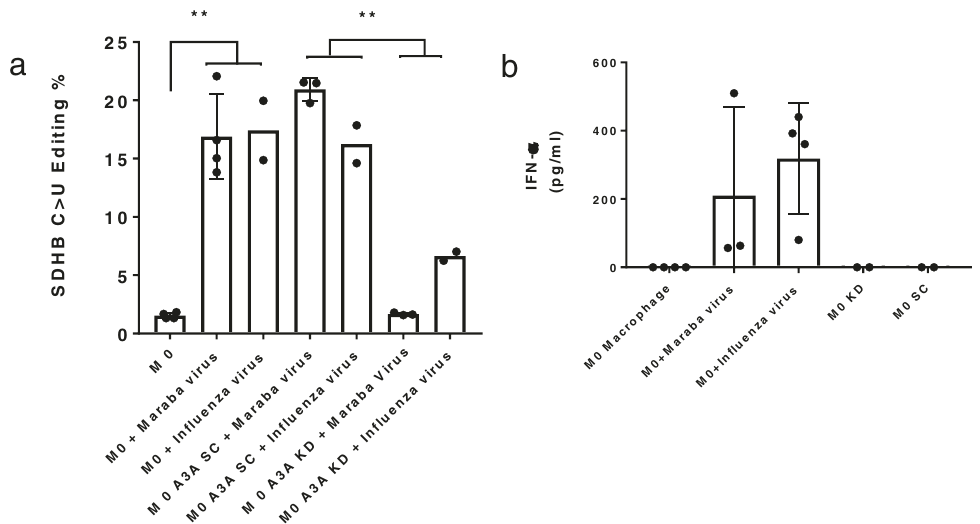
Fig. 2 Viruses induce A3A-mediated RNA editing in macrophages. Circulating healthy donor monocytes (~1 × 10 6 cells per well) were differentiated into M0 macrophages followed by siRNA transfection (A3A knock-down [KD] or scramble [SC]). After 24 h, were infected with Maraba (10 6 PFU per well) or in fl uenza virus (2 × 10 4 PFU per well, MOI = 0.02), and SDHB RNA editing was assessed at 48 h after infection: n = 3 donors for Maraba and n = 2 donors for in fl uenza viruses. a Viral infection of M0 macrophages increased SDHB RNA editing levels. ** P = 0.0095, Mann – Whitney test, two-tailed. A3A KD signi fi cantly reduced SDHB RNA editing levels induced by viral infections. ** P = 0.0079, Mann – Whitney test, two-tailed. b IFN- α levels in culture supernatant increased after Maraba or in fl uenza virus infections, but were undetectable after siRNA (SC or A3A KD) transfections. n = 2 – 4 donors. Data in scatter dot plots with mean ± SD.